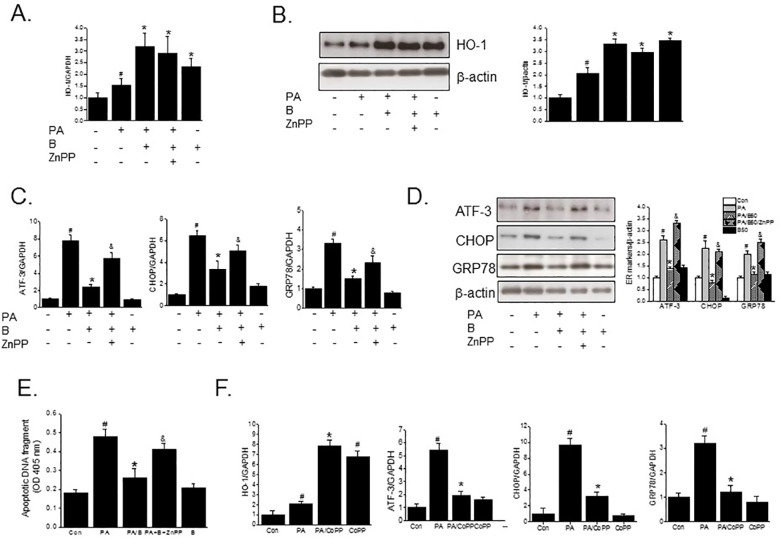
Involvement of HO-1 upregulation in the protective effect of baicalein on PA-mediated lipotoxicity.INS-1 cells were pretreated with or without ZnPP (10 μM) for 30 min, followed by baicalein (50 μM) for 3 h and then PA (500 μM) for a further 8 h (for qPCR) or 24 h (for western blot). The mRNA expressions (A and C) and protein (B and D) levels of HO-1 or ER stress markers were assessed by qPCR or western blotting, respectively. Apoptotic DNA fragmentation was assessed using a Cell Death Detection ELISA Plus kit (E). INS-1 cells were pretreated with CoPP (10 μM) for 1 h, followed by PA (500 μM) for a further 8 h, and mRNA expressions were determined by qPCR (F). The results shown are representative of three independent experiments and are expressed as means ± SDs. #P<0.05 vs. controls; *P<0.05 vs. PA alone; &P<0.05 vs. PA plus baicalein treatment.